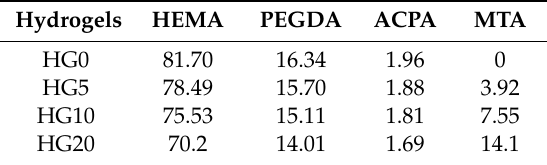
Table 1. The weight percentage of chemicals used for the hydrogels preparation. Hydrogels HEMA PEGDA ACPA